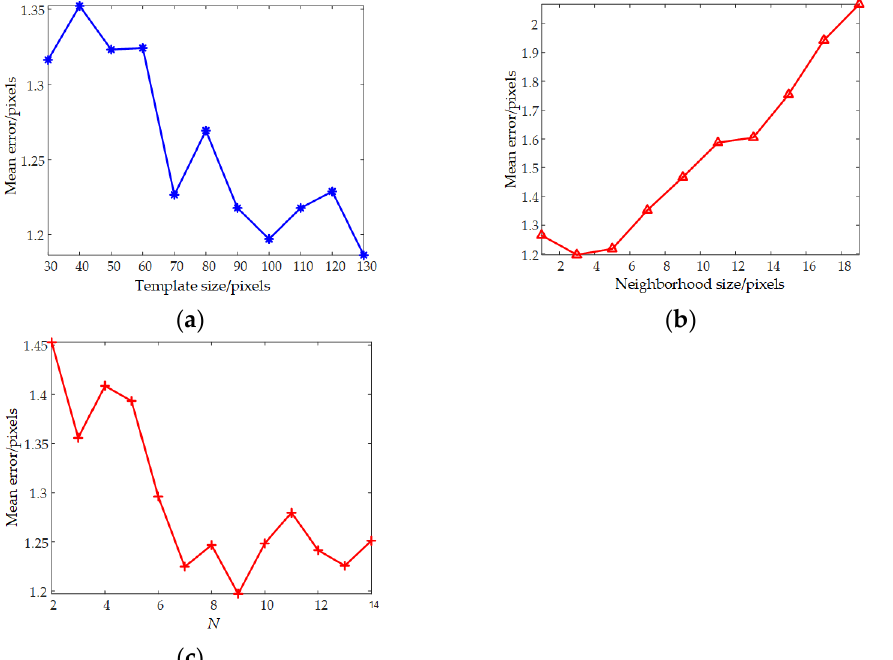
Figure 18. The effect of parameter settings on the mean error. ( a ) Template size changes; ( b ) feature neighborhood size changes; ( c ) feature directions.